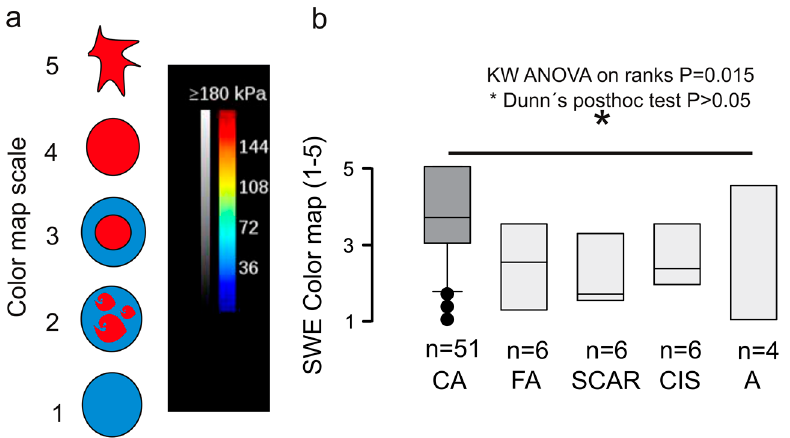
Figure 7. Qualitative elastography assessment. ( a ) Qualitative evaluation of the elastogram in a scale 1–5 with criteria similar to the Tsukuba–Ueno scale ( b ) Box plot showing the median and interquartile range, dots within the 5–95th percentile. Cancer (CA, n = 62 tumors) and benign lesions (n = 32 tumors), p = 0.015, Kruskal–Wallis ANOVA on ranks with Dunn’s post-hoc test. Note that the qualitative elastogram grading cannot be blinded to the B-mode features, which is a likely source of bias. FA, fibroadenoma; SCAR, scar; CIS, cancer in situ; A, adenosis.